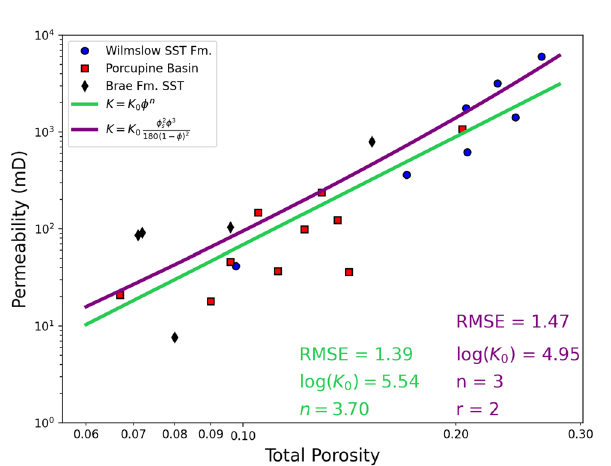
Figure 4. Range of calculated fit configurations to the porosity–permeability relationship which incorporate grain characteristics using Kozeny–Carman based relationships. The table to the right describes the difference between each fit line and reports the values of the exponents whilst the respective equations are displayed in the plot legend.